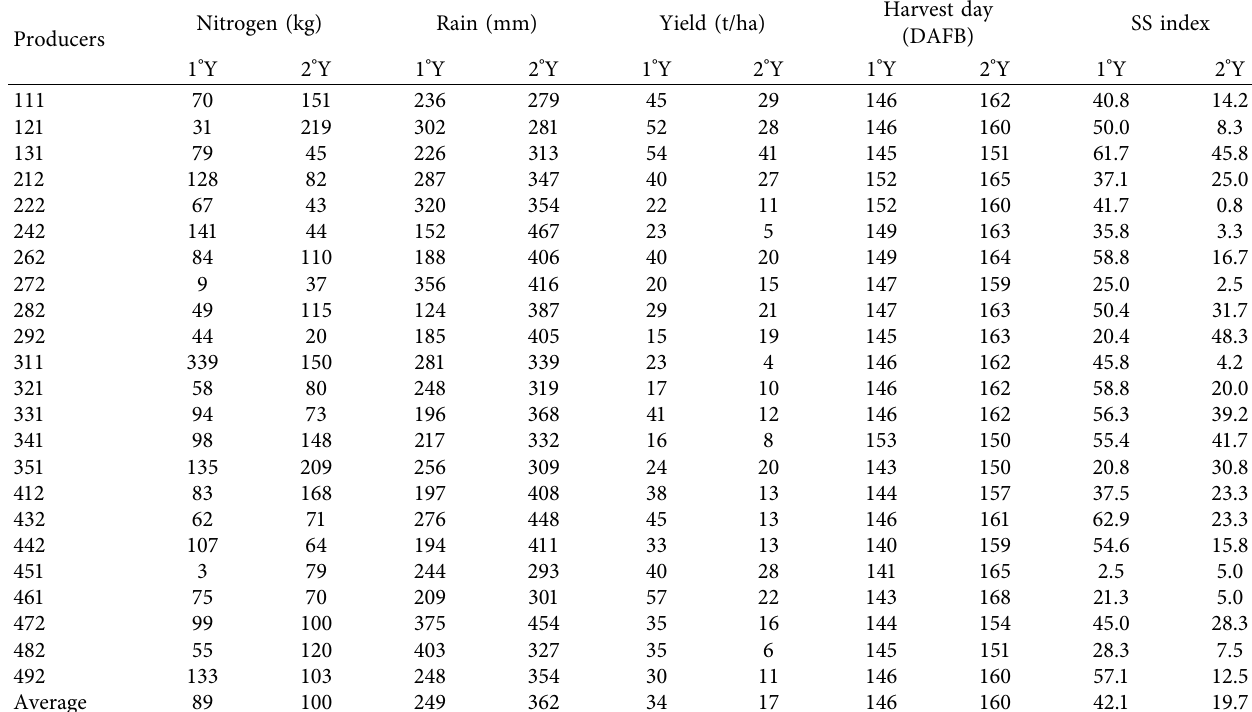
Figure 1: Discriminant canonical analysis (DCA) that describes the behaviour of superficial scald in “Abate Fetel” pears (the blue vectors are clas0 0%, clas1 1%–25%, clas2 26–50%, and clas3 51–100% of peel symptoms) and farm scores (coloured points) in two seasons (2018-2019 and 2019-2020). Percentages in parentheses represent the variance of each component (Can1 and Can2). The following abbreviations have been used for the epochs of sampling from cold rooms after 3 months in 2018 (1.1) and 2019 (1.2), 4 months in 2018 (2.1) and 2019 (2.2), 5 months in 2018 (3.1) and 2019 (3.2), and 5 months with 1-MCP in 2018 (4.1) and 2019 (4.2). Table 1: Changes in preharvest factors (kilograms of nitrogen from fertilization, millimetres of rain during the growing season, yield in tons per hectare, harvest day expressed as day after full bloom (DAFB) and SS index after 5 months of storage of “Abate Fetel” producers between the first season (2018) and the second season